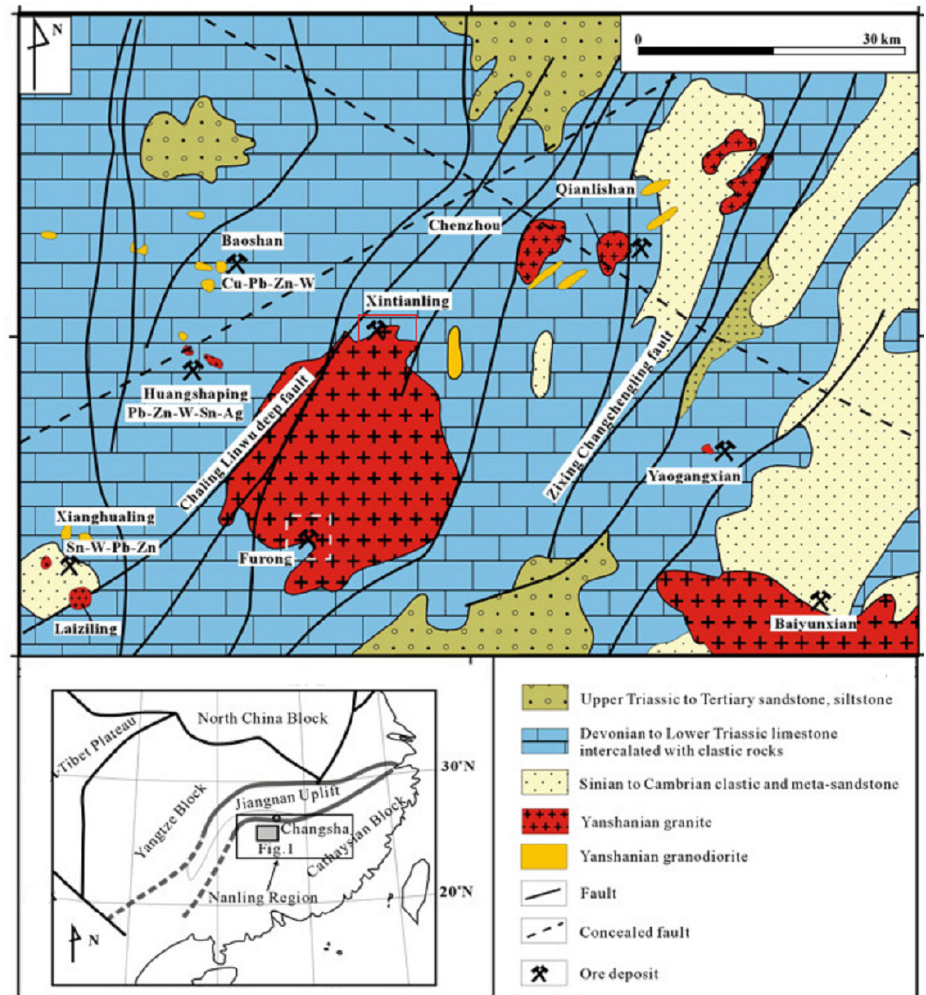
Figure 1. Simplified geological map of central Nanling region, South China, and distribution of mineral deposits in the region. (Peng et al. 2006) [5] .